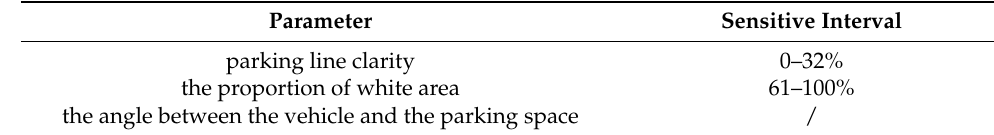
Table 2. Model sensitivity